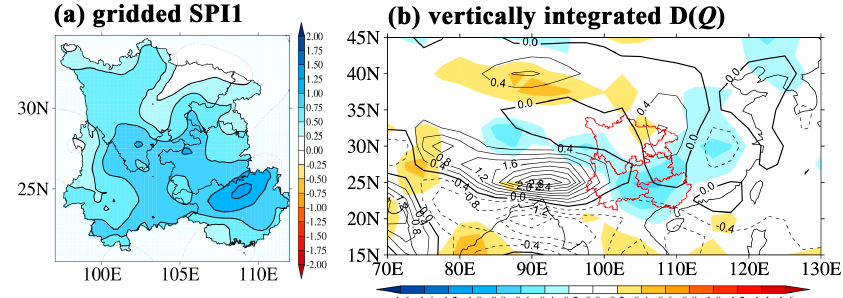
Figure 7. Composite of: ( a ) gridded SPI1; and ( b ) vertically integrated water vapor flux divergence (D( Q ); contours) and its standardized anomalies (SA; shadows) during wetter processes in Southwest China (SWC). The unit of D( Q ) is 10 − 4 ·kg·s − 1 ·m − 2 .